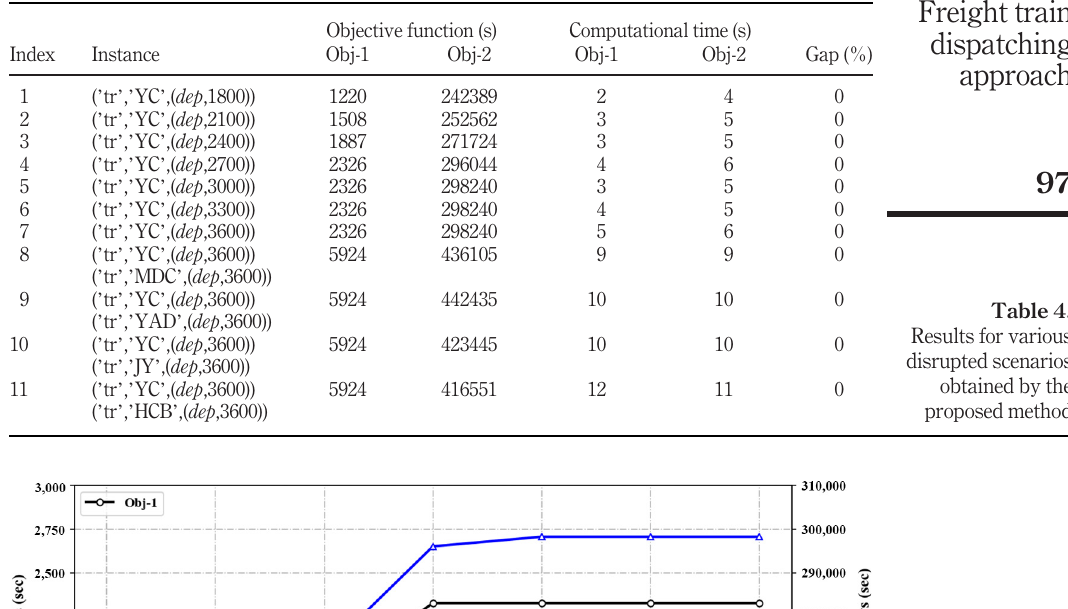
Figure 9. Values of two objective functions with